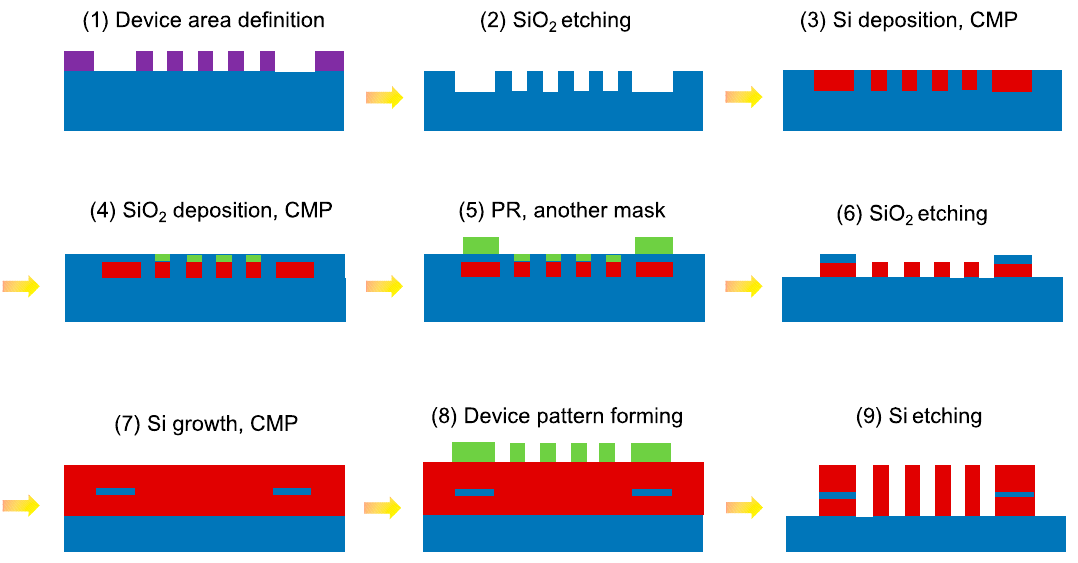
Figure 2. Schematic diagram of the fabrication processes of the designed PBS.